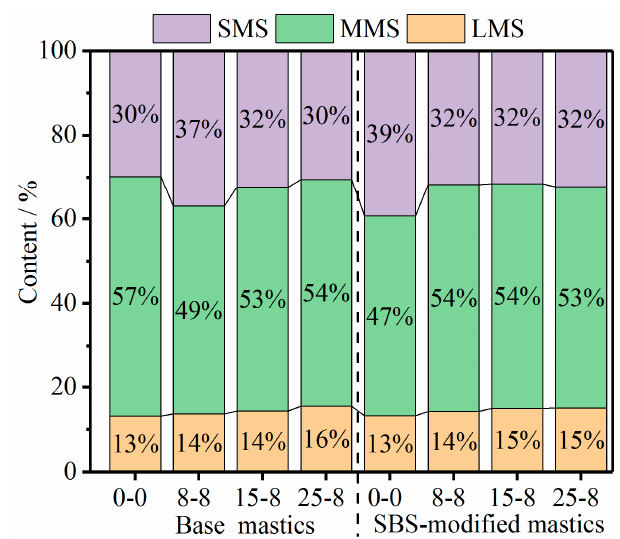
Figure 10. Large molecular size (LMS), medium molecular size (MMS), and small molecular size (SMS) ratio changes of the mastics.